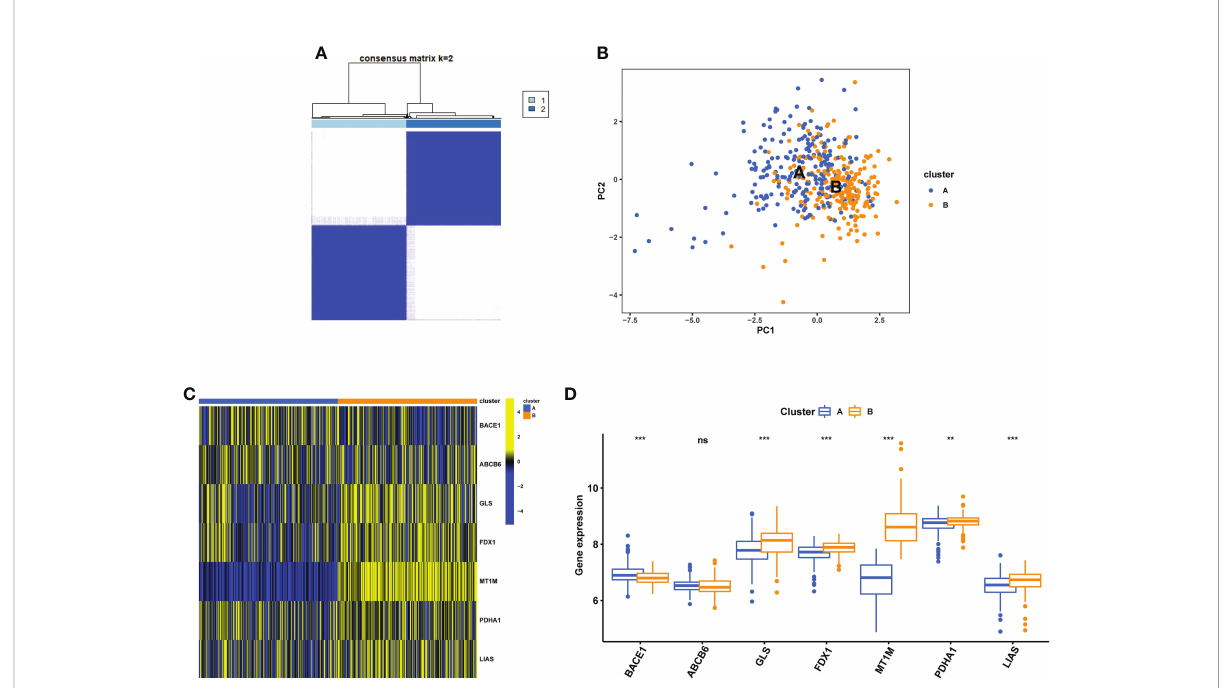
FIGURE 8 Identi fi cation of cuproptosis subtypes in CD. (A) Subclusters were performed with differential genes. (B) PCA diagram showing the distribution of different subclusters. Heatmap (C) and boxplot (D) show differential expression of CuDEGs between subtypes. ns, no signi fi cance; ** represents p < 0.01; *** represents p <